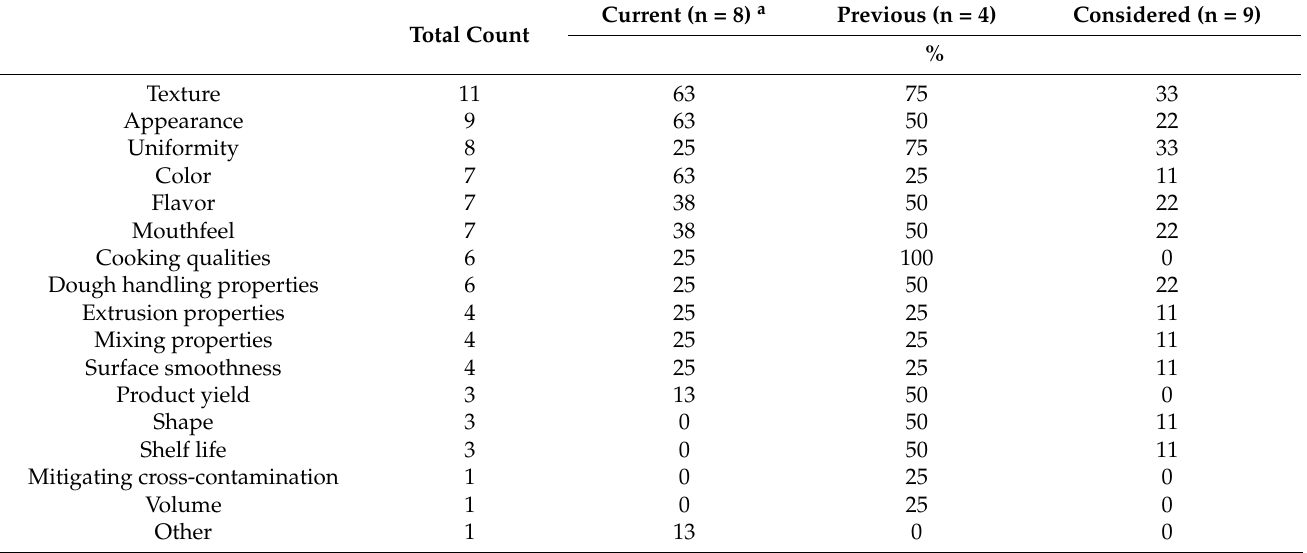
Table 9. Satisfactory product qualities produced using the pulse flours that the CPC users selected.